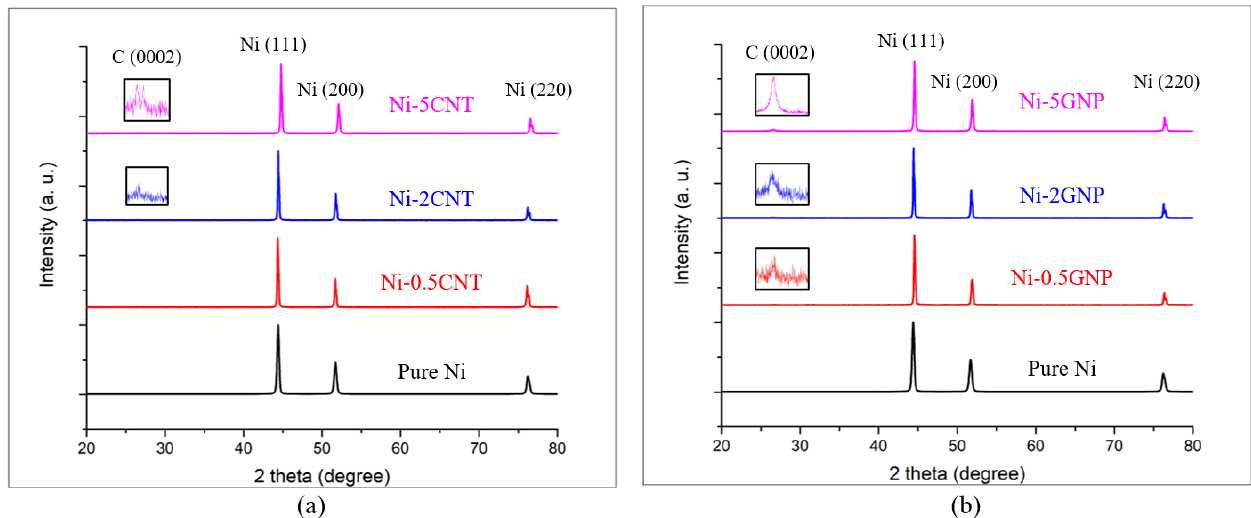
Figure 2. X-ray diffraction (XRD) pattern for ( a ) pure Ni and Ni-CNT composites; ( b ) pure Ni and Ni-GNP composites.